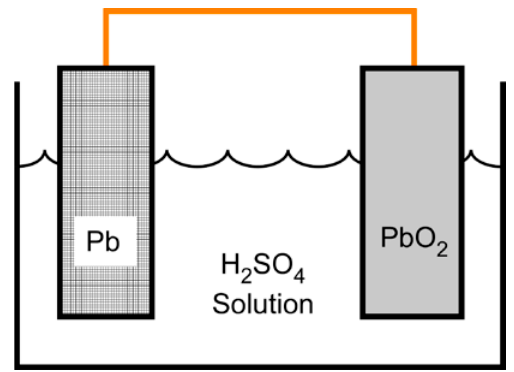
Figure 7. Diagram of a lead-acid